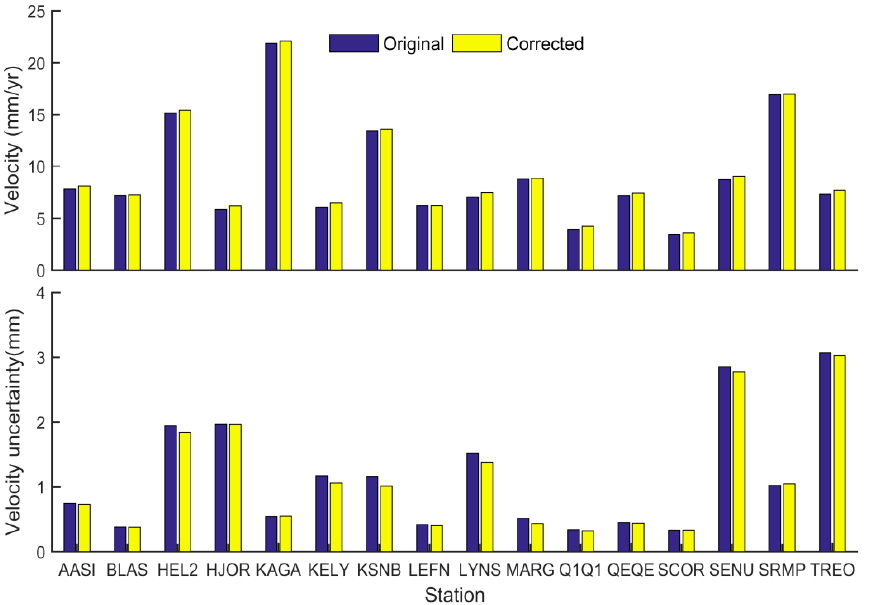
Figure 15. The variation of GPS station velocity ( top ) and uncertainty ( bottom ) based on the optimal noise model.